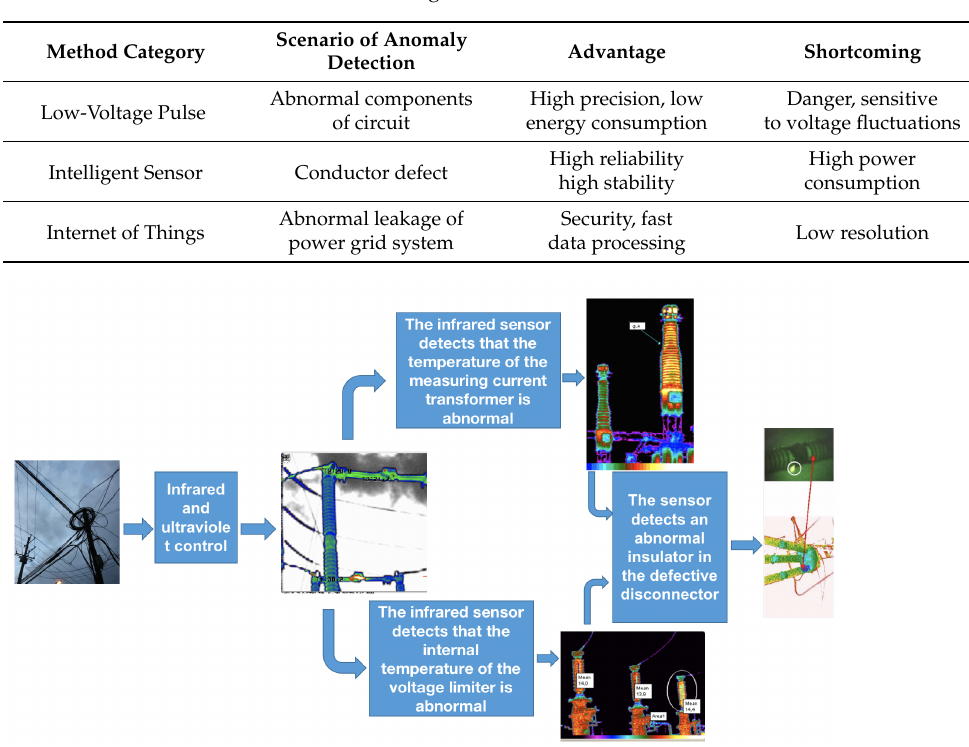
Table 2. In view of the abnormal phenomena in the power grid environment, we use the following three kinds of abnormal detection technologies and methods.